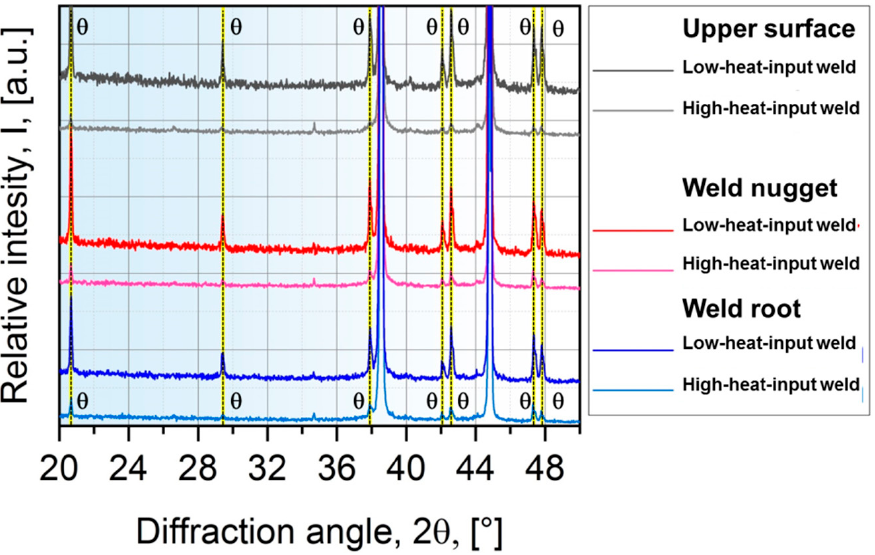
Figure 7. X-ray diffraction spectra taken from different locations of low-heat-input weld and high- heat-input weld. For clarity, the peaks associated with θ -phase are indicated by dotted lines.